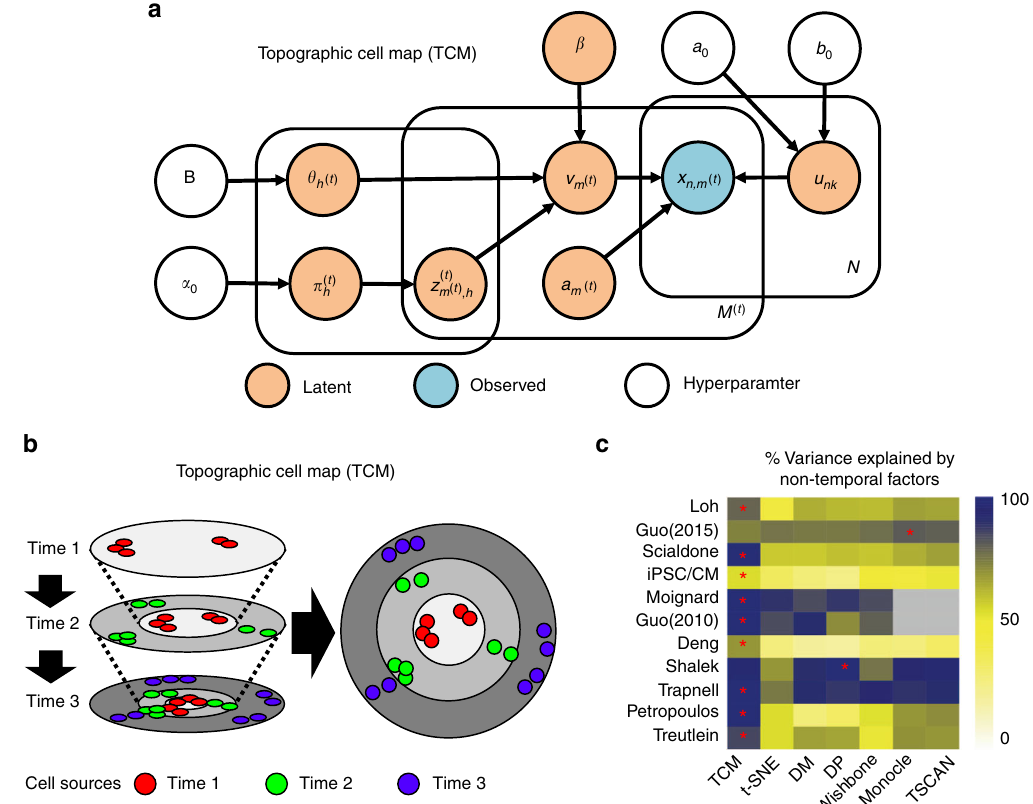
Fig. 1 TCM reduces the variance due to temporal factors on the latent space . a Graphical model representation of TCM. The boxes are “ plates ” representing replicates. The left plate represents prototypes, the middle plate represents cells and the right plate represents genes. b In TCM, the cells from each time point are simultaneously mapped to multiple time point speci fi c latent spaces, preventing the cells from the same time points crowding together due to the high temporal variance usually present in the time series expression datasets. To reconstruct the global developmental trajectories, the time point speci fi c latent spaces are convolved together to produce a single latent space where cells from early and late time points distribute at the center and periphery, respectively. c The heatmap indicates the percent of variance explained by non-temporal factors on the two dimensional latent space produced by TCM, t-SNE, diffusion map (DM), diffusion pseudotime (DP), Wishbone, Monocle, and TSCAN on 11 examined single cell expression datasets. The lower percentage suggests the latent space is more dominated by the temporal variance. The red asterisk indicates the method that provides the highest percent of variance explained by non-temporal